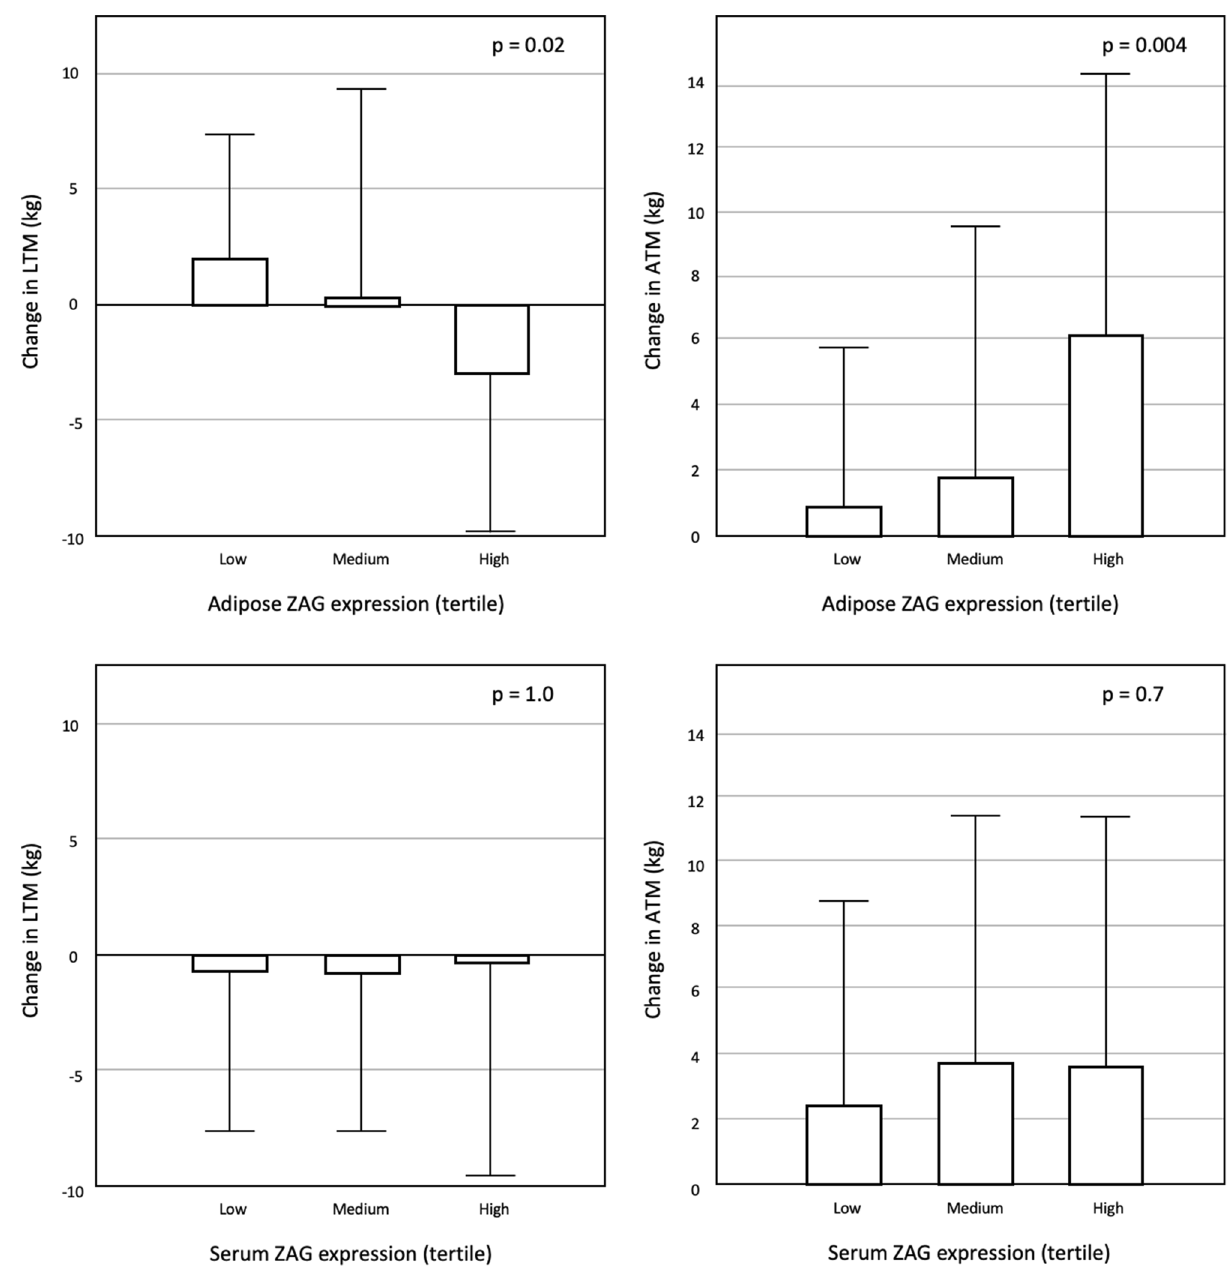
Figure 3. Change in lean and adipose tissue mass with adipose and serum ZAG expressions.